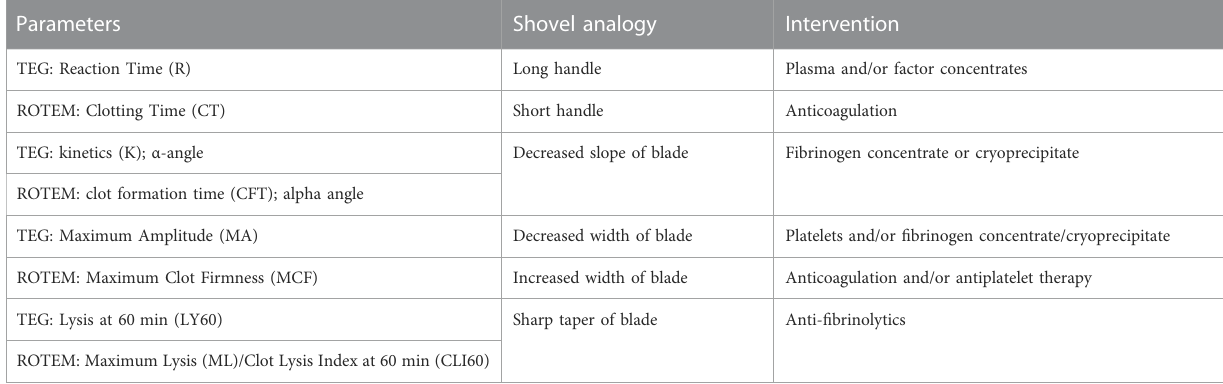
TABLE 2 Goal-directed blood components and hemostatic adjuncts based on the shovel analogy of TEG/ROTEM. Parameters Shovel analogy